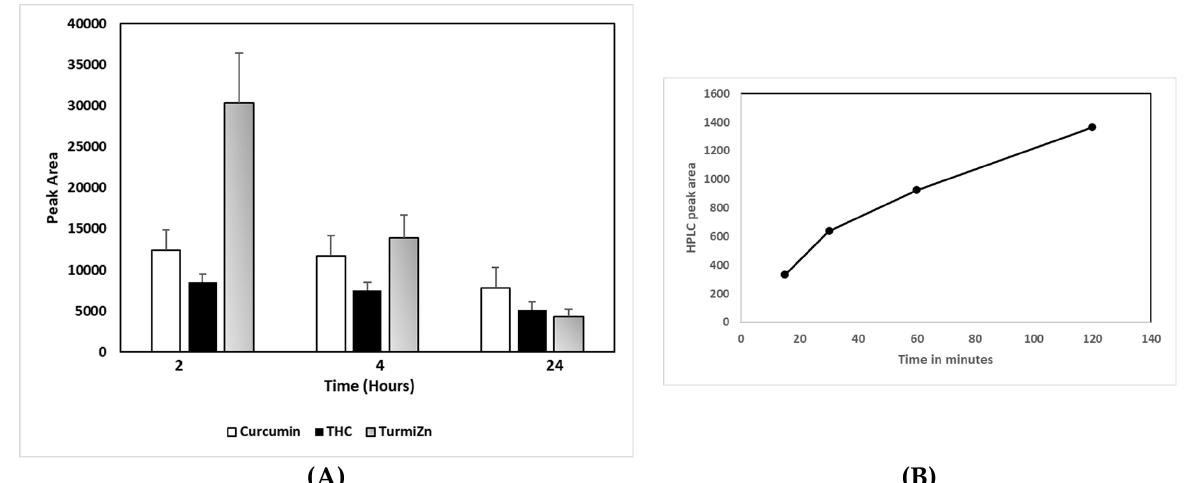
Figure 3. ( A ): TurmiZn HPLC peak area at 1.8 minutes retention time over 24 hours in chicken plasma. ( B ): Time course of oral TurmiZn in rat plasma of LC peak area at 10.55 min retention time. Values are mean ± standard error of the mean.